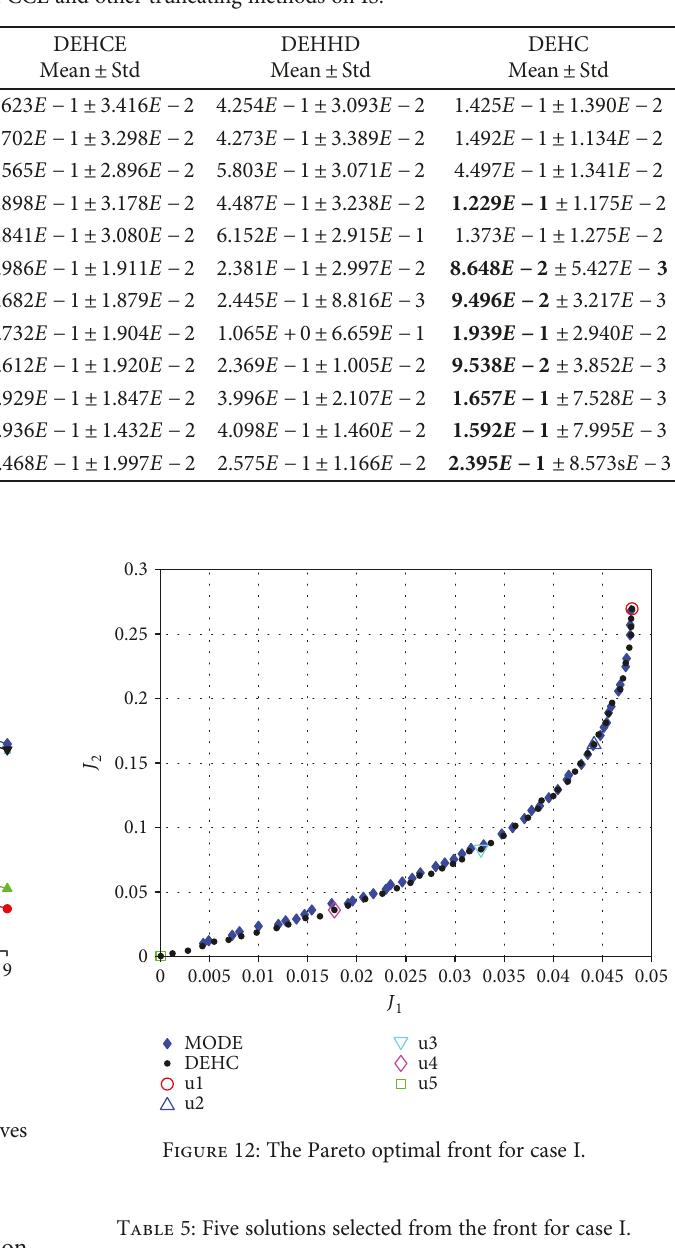
Table 4: Comparison results of CCE and other truncating methods on IS .